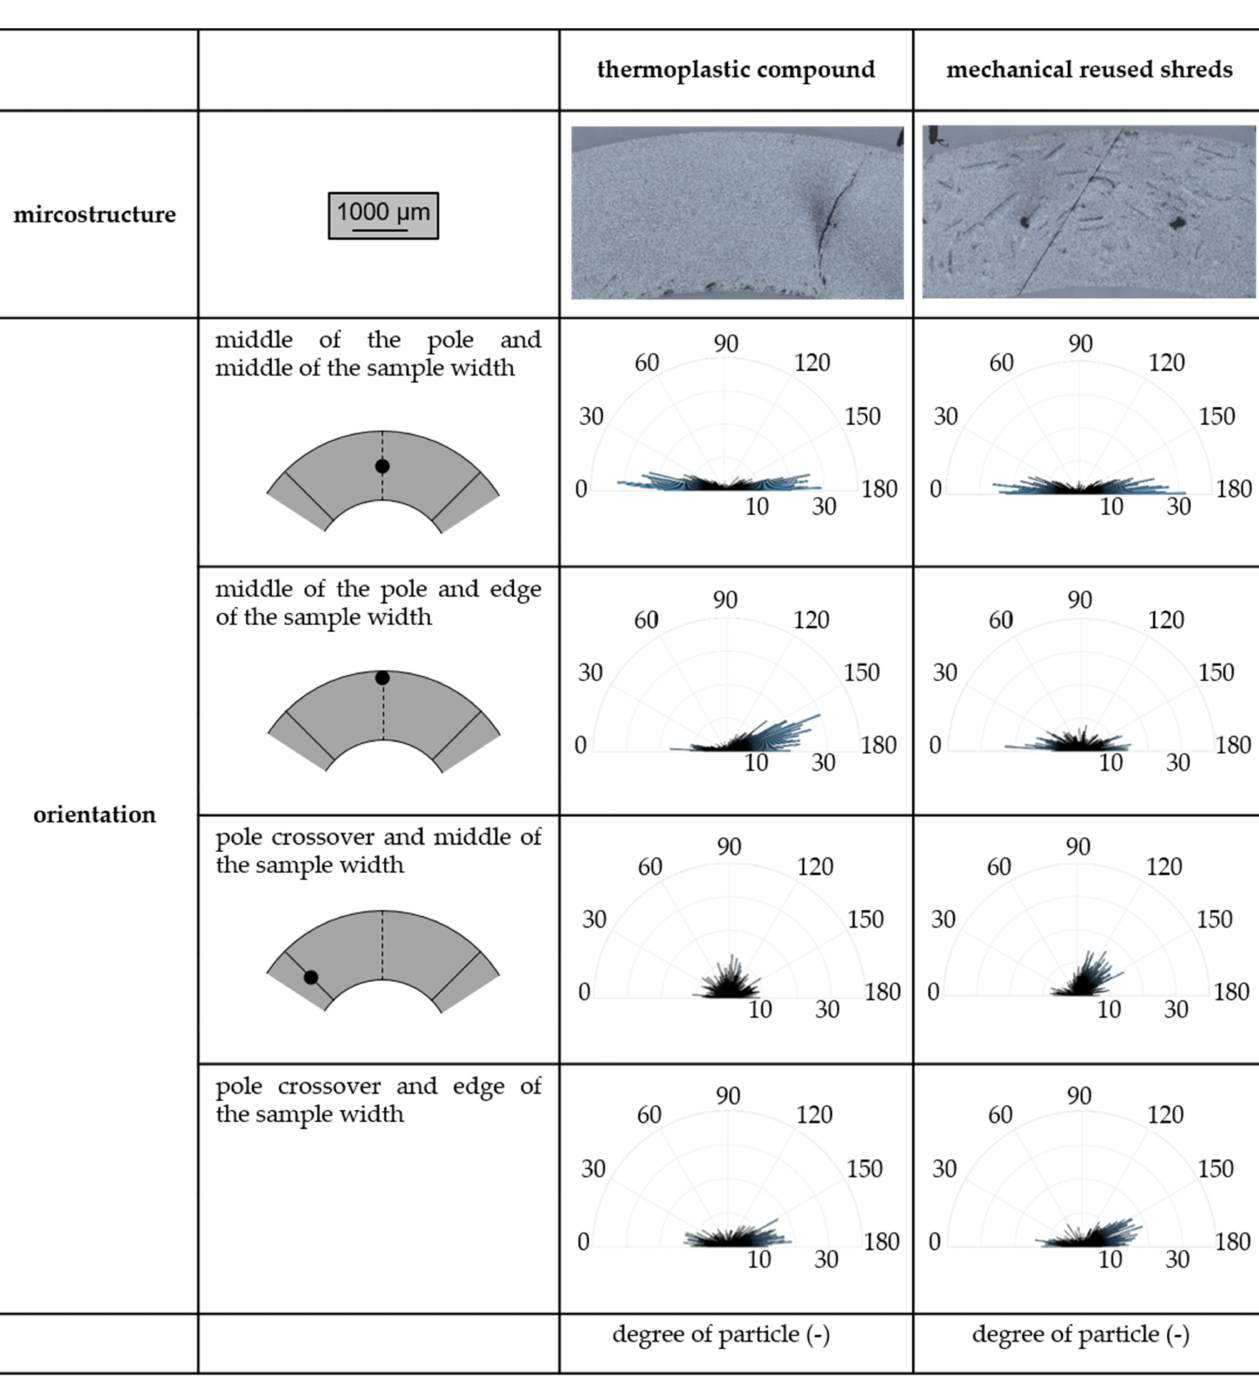
Figure 14. Comparison of the microstructure and the orientation at different positions in the sam- ple relative to the pole crossover or middle and to the edge or middle of the sample width for thermoplastic compound and mechanically reused